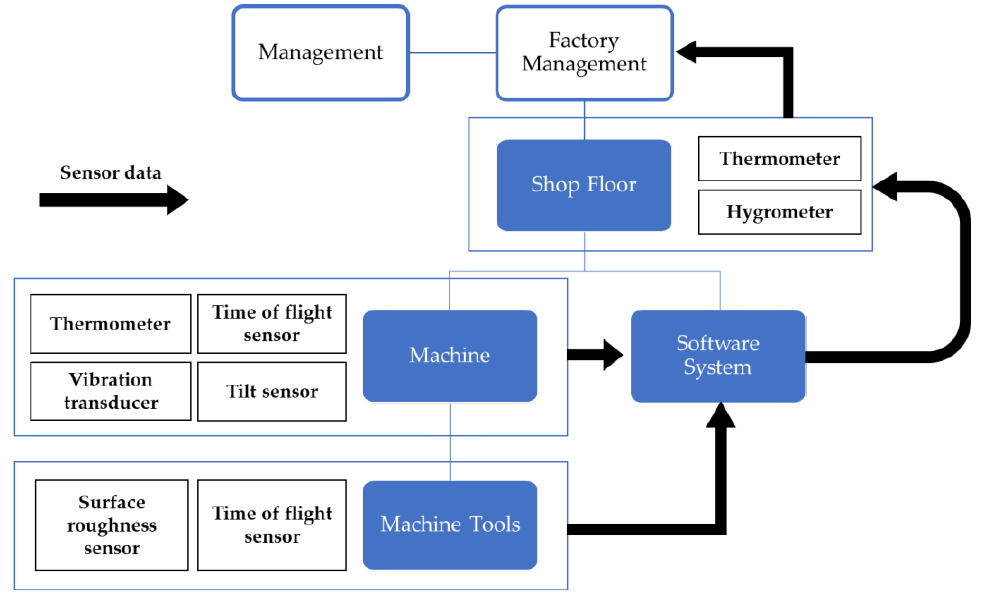
Figure 2. Data acquisition and flow in the RMS.